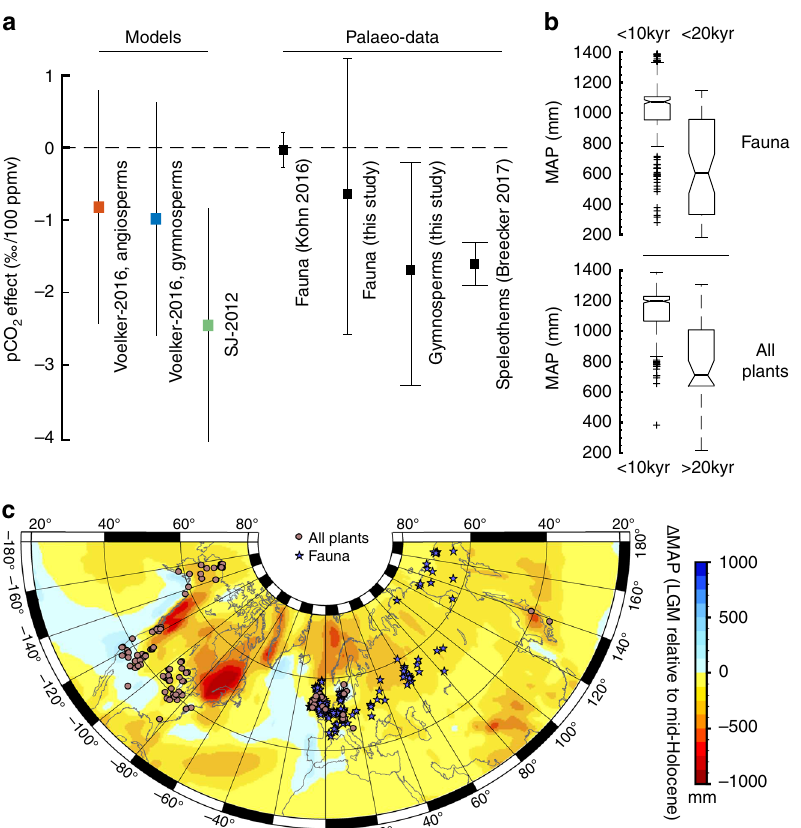
Fig. 3 Effect of atmospheric pCO 2 on mean stable carbon isotope composition over the last deglaciation, determined from terrestrial records and from changes in MAP. a Magnitude of pCO 2 effect predicted by models and palaeo-data. Error bars for models, fauna, and gymnosperms (all this study) and speleothems 16 are 1 σ propagated uncertainties, and 2 s.e. for fauna from Kohn 15 . b Changes in MAP predicted by PMIP3-CMIP5 multi-model ensemble between the LGM and mid-Holocene, used to constrain the pCO 2 effect on our data set. c Geographical distribution of our data, showing the magnitude of MAP changes predicted by the multi-model ensemble over the same time